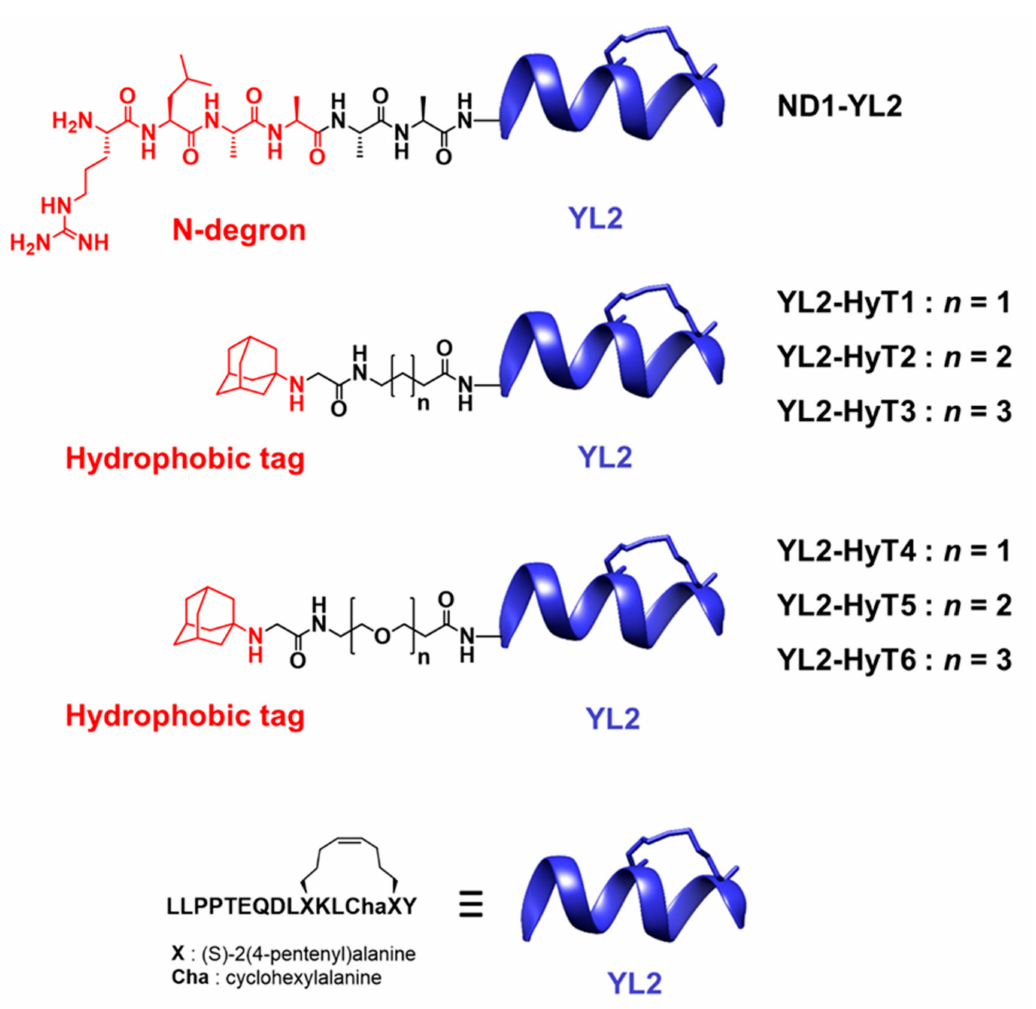
Figure 2. Chemical structures of ND1-YL2 and hydrophobic-tag-conjugated stapled peptides (YL2-HyT1–6). Although ND1-YL2 displays robust SRC-1 degradation and inhibitory activity